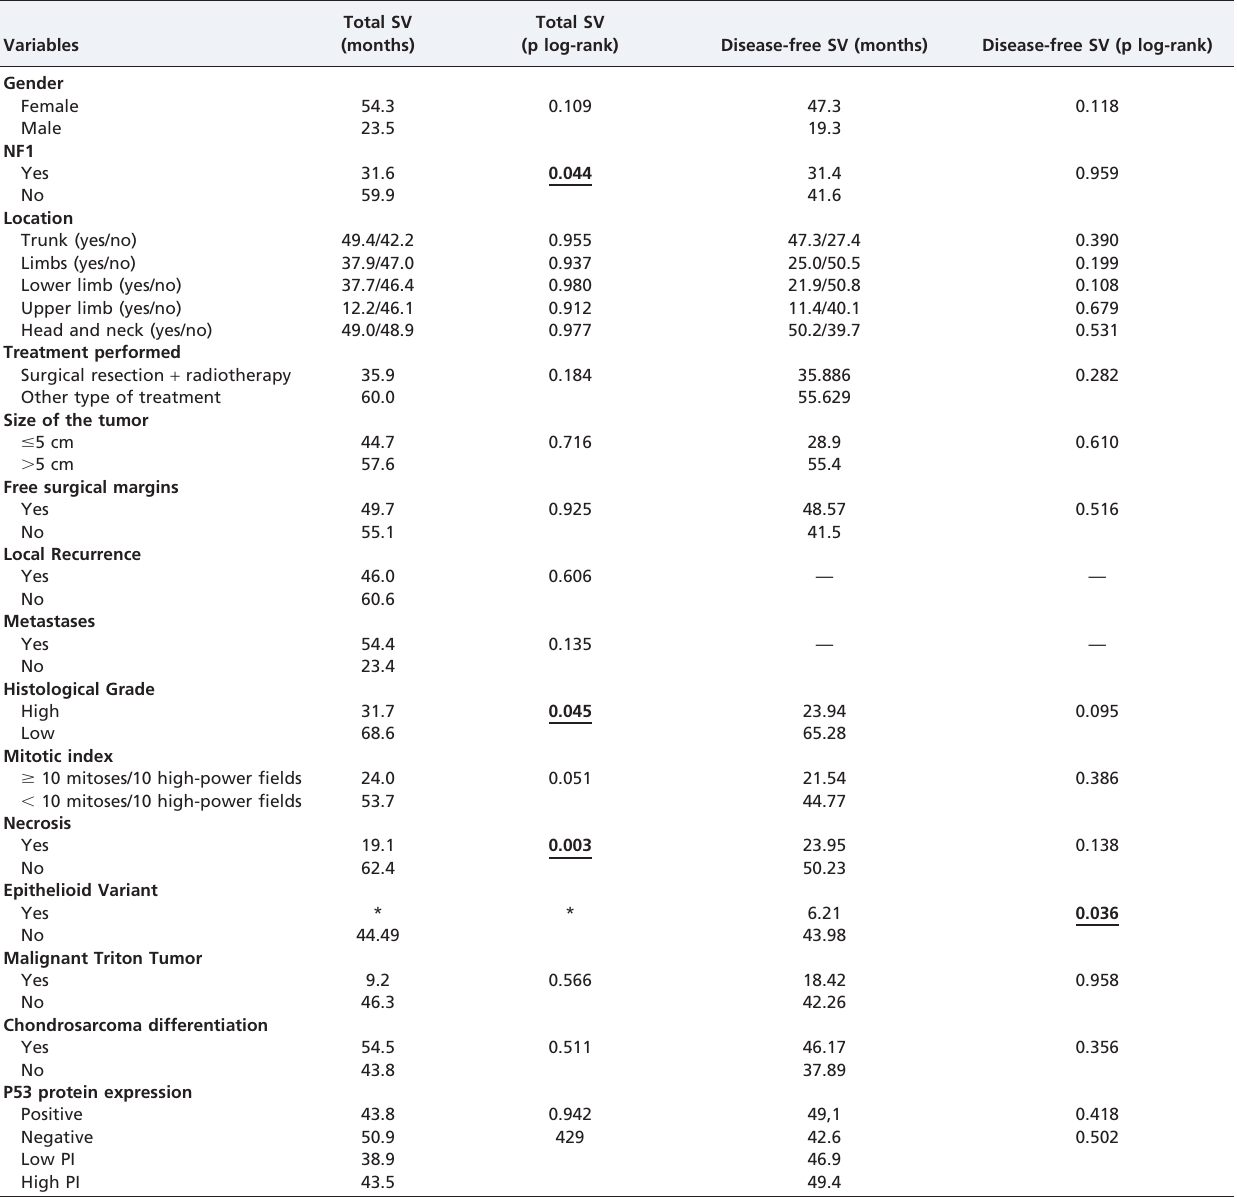
Table 4 - Results of the influence of the clinicopathological variables on the overall and disease-free survival in patients with malignant peripheral nerve sheath